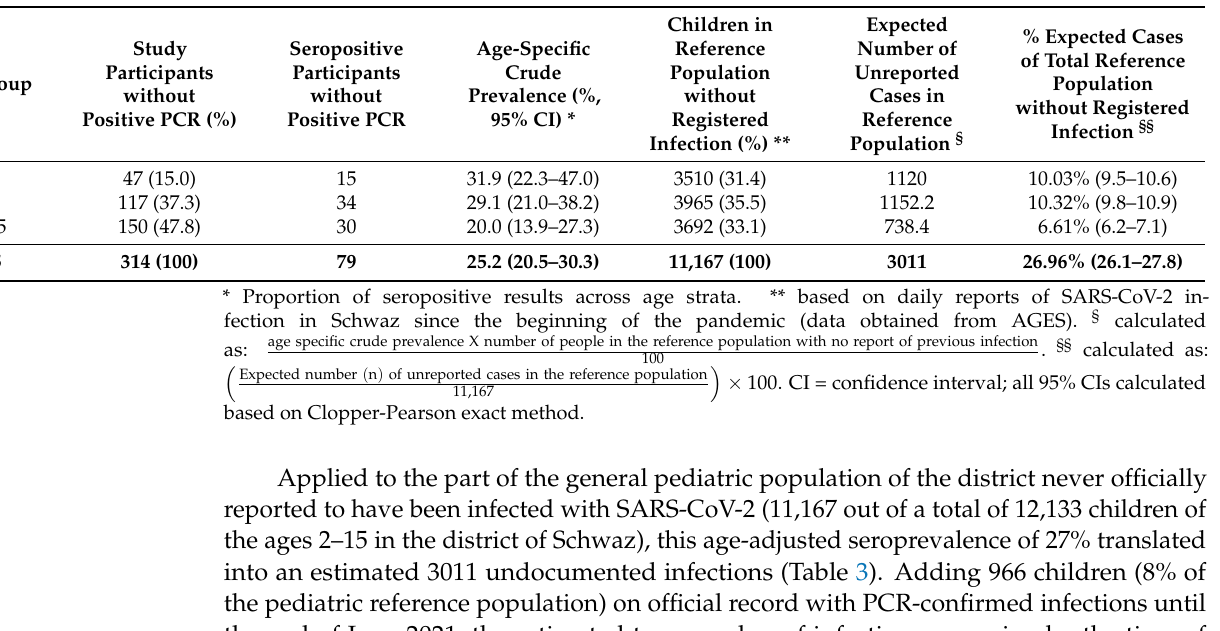
Table 3. Characterizing study population and source population without a known history of officially reported SARS-CoV-2